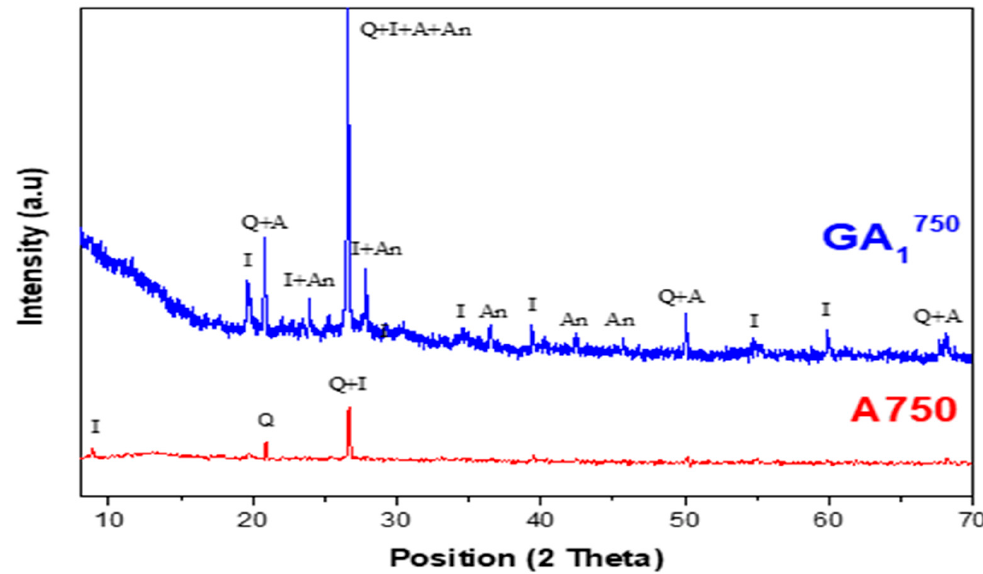
Figure 9. Diffractograms of GA 1750 geopolymer aged 7 days and A750 clay with Q—Quartz (01-082- 0511), I—Illite (00-026-0911), A—Aluminum phosphate (01-084-0853), An—Anorthite (00-012-0301).